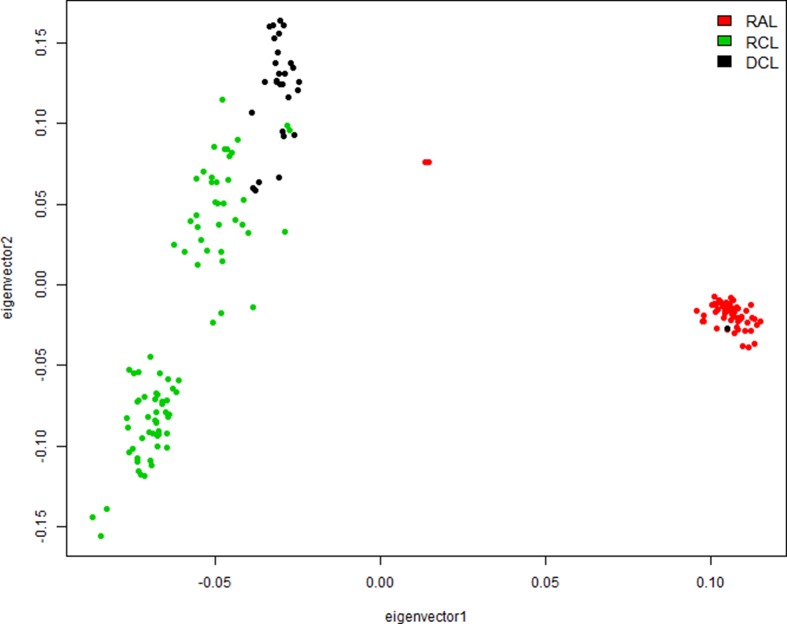
Population structure identified by the principal component analysis (PCA). DCL, RAL, and RCL represent dark comb line, random line, and red comb line chickens, respectively.